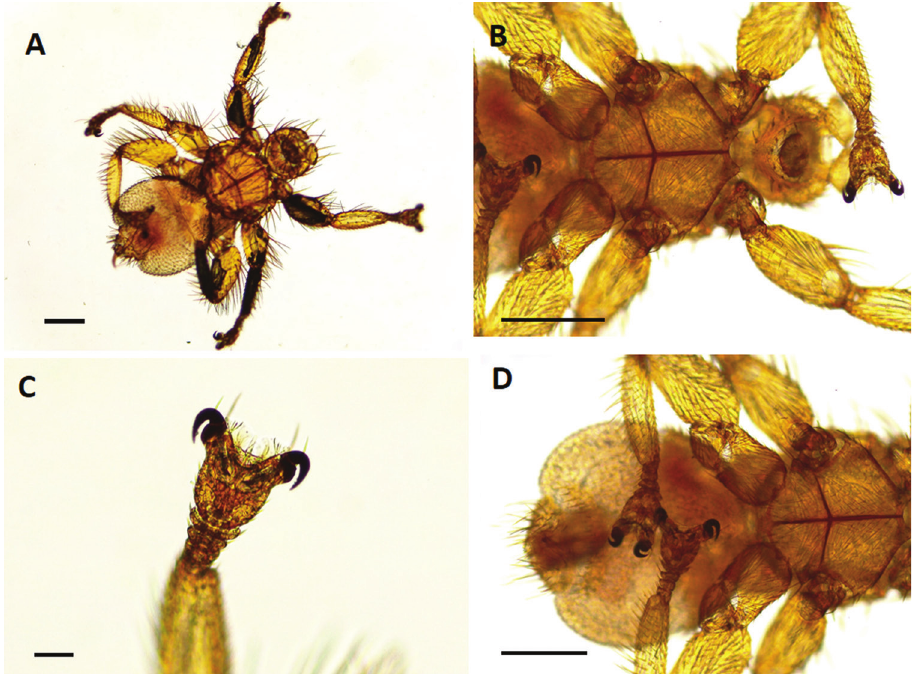
Figure 2. A dorsal view of Exastinion clovisi , 40× magnification B detail of thorax, 100× C distal detail of the leg, 100× D detail of abdomen, 100×. Leica DM500 optical microscope. Scale bars: 0.5 mm ( A, B, D ); 0.1 mm ( C ).